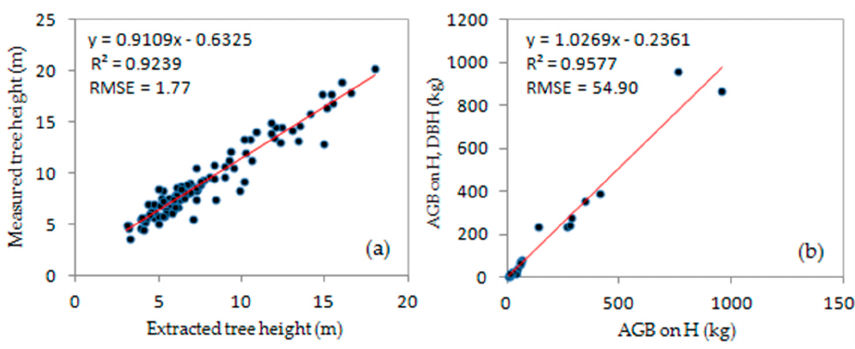
Figure 13. Accuracy assessment of extracted individual Minjiang tree heights and the AGB estimation only based on individual tree heights.